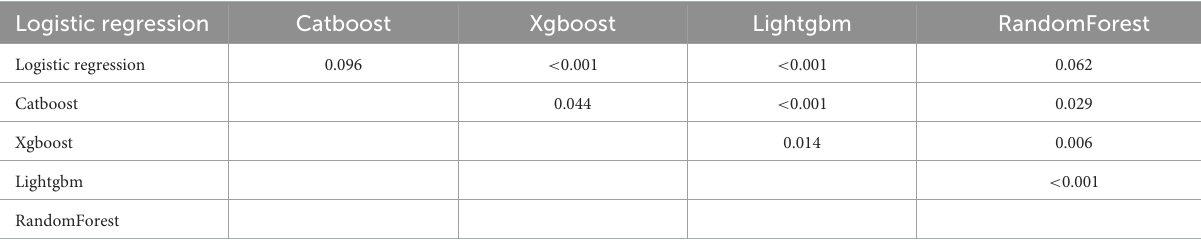
TABLE 4 P -values of the pairwise statistical comparisons of the ML model AUC (overall early death) values derived from the bootstrap test.